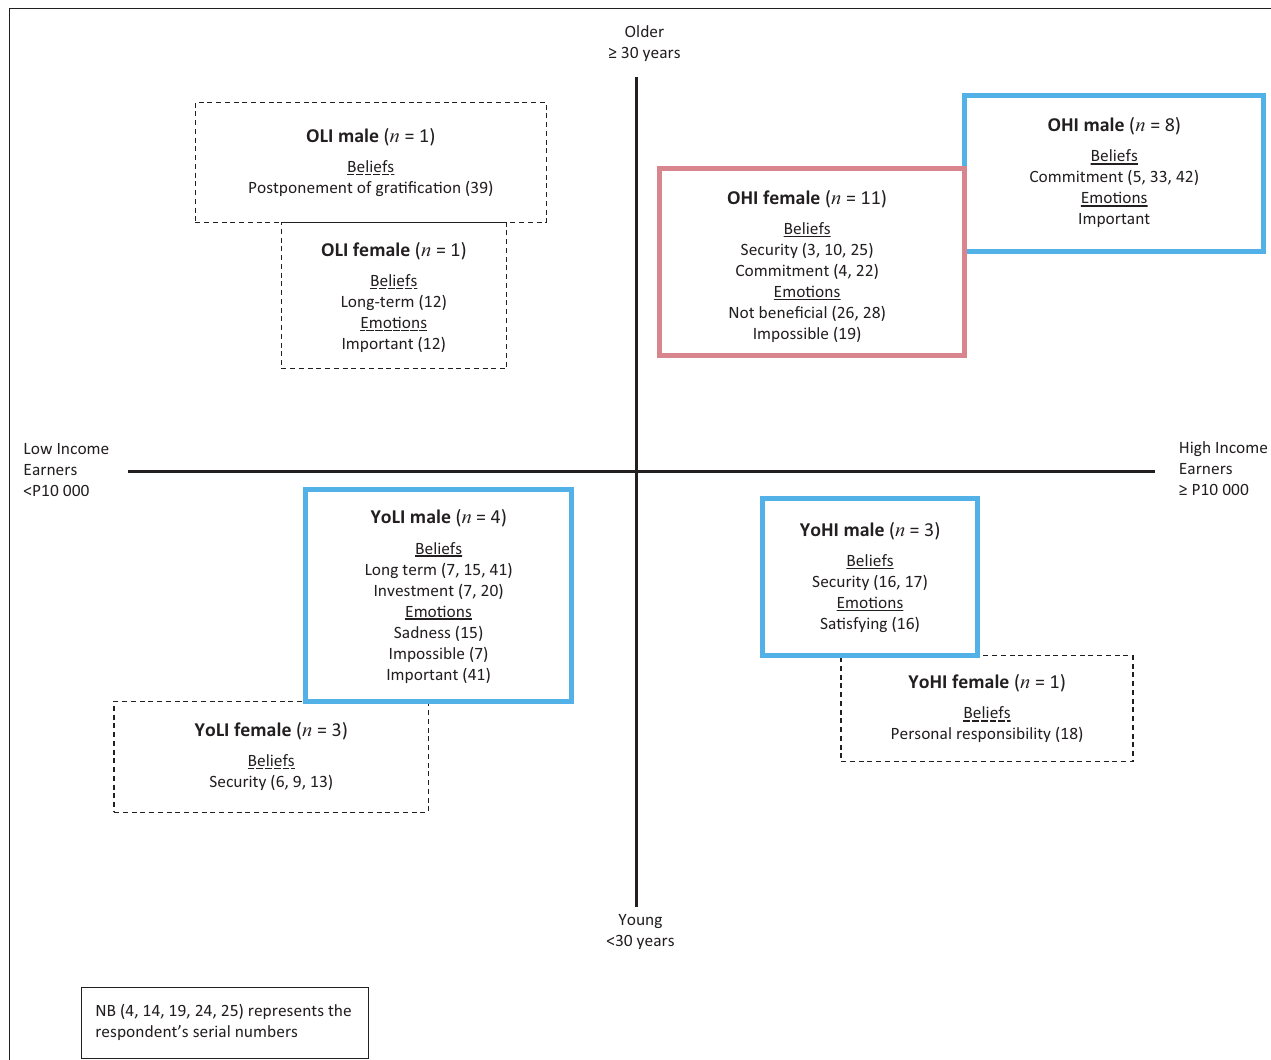
FIGURE 3: Attitudes of